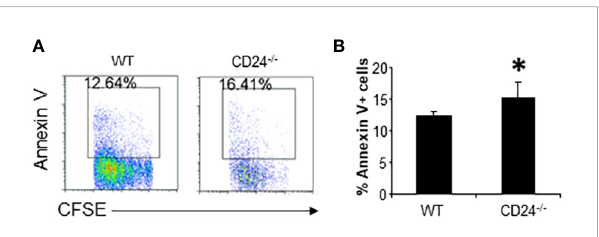
FIGURE 2 2D2 T cell survival in lymph nodes of CD24 -/- and WT mice. (A) . Flow cytometry analysis of 2D2 T cell death in draining lymph nodes of WT and CD24 -/- mice. Data shown are gated on V b 11 + CFSE + cells. 5 x 10 6 CFSE-labeled 2D2 T cells were injected into WT or CD24 -/- mice i.v. followed by immunization with MOG 35-55/CFA. (B) . Percent of Annexin V + 2D2 T cells in the draining lymph nodes of WT and CD24 -/- mice. Five mice per group were used for the experiment. *p<0.05, student ’ s t test was used for the comparison. Data represents 8 experiments with similar results.